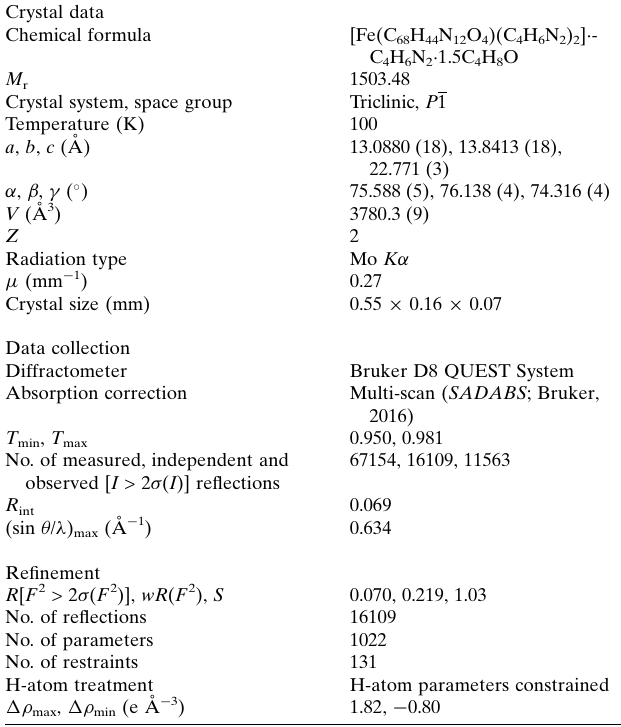
Table 2 Experimental details. Crystal data Chemical formula